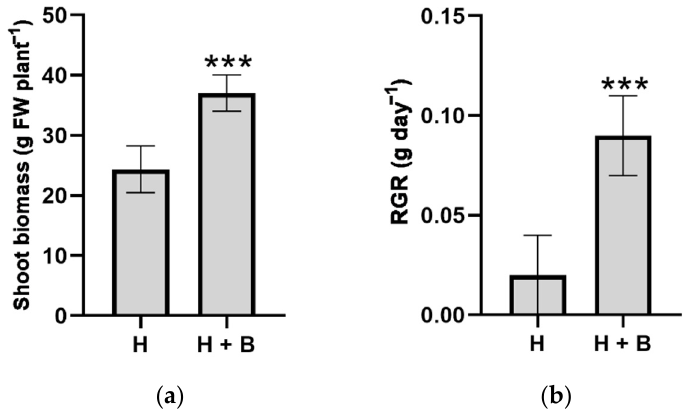
Figure 2. Biomass production ( a ) and relative growth rate (RGR) ( b ) of shoot of sunflower plants subjected to the treatments (H: Pulsar 40; H + B: Pulsar 40 + Terra-Sorb ® ). Values are expressed as means ± standard error ( n = 9). The level of significance was p < 0.001 (***). The analysis of ALS enzyme activity is the main indicator of the phytotoxic effect of imidazolinone-type herbicides such as Imazamox (Pulsar 40) when used in sunflower